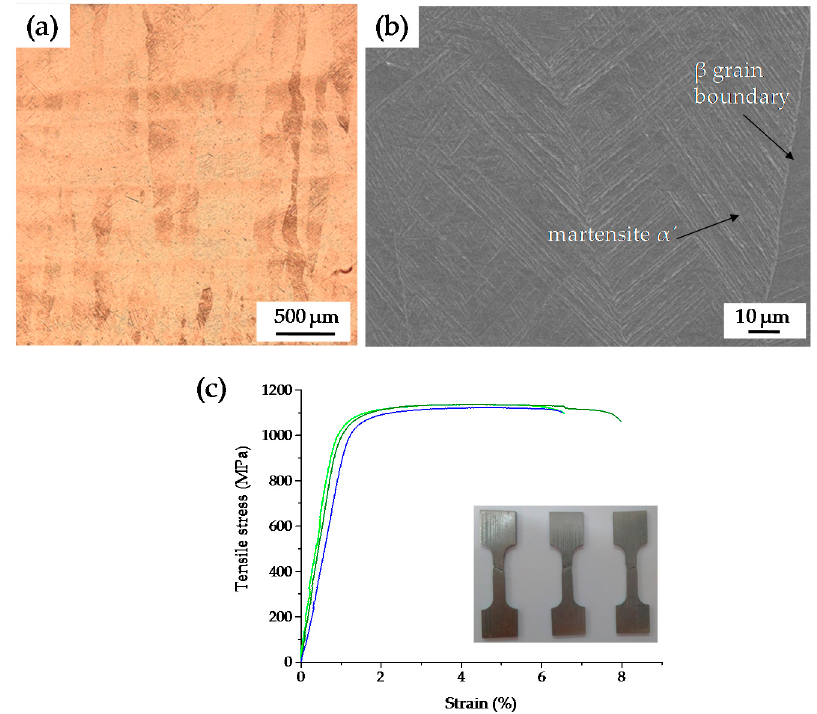
Figure 11. The sample with greatest density and fastest building rate was fabricated at a scanning speed of 60 mm/s and hatch spacing of 0.5 mm. ( a ) optical micrograph of columnar prior- β grains; ( b ) SEM image of the typical martensite microstructure; ( c ) Stress-strain plots of the sample. Table 3. Tensile properties of SLM samples at thick layer thickness (200 μ m) and thin layer thicknesses (0 μ m–50 μ m).